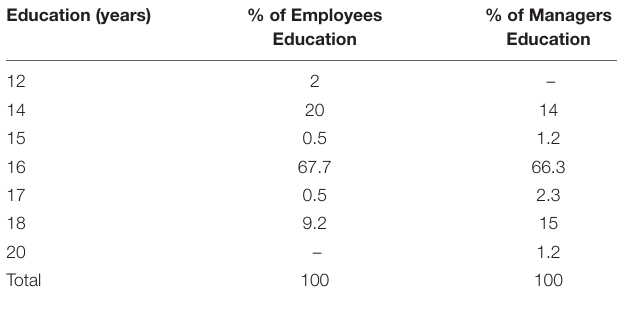
TABLE 1 | Education level of